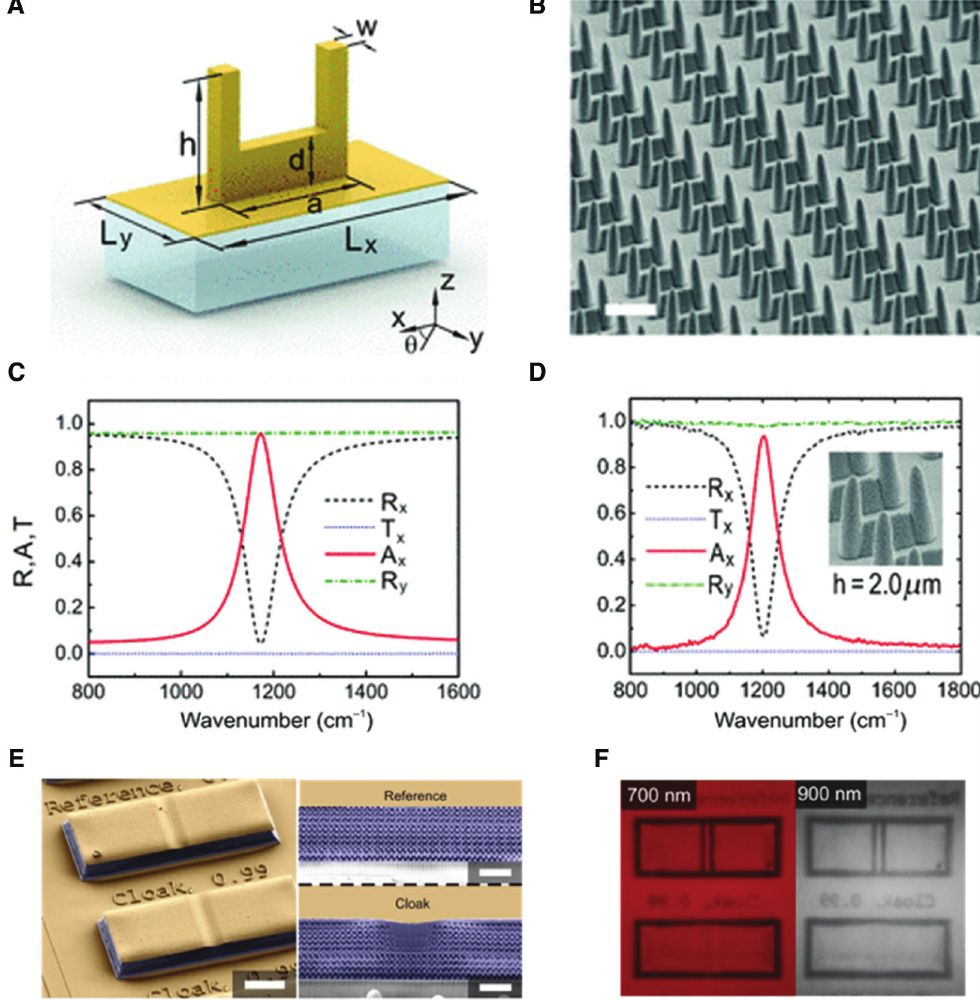
Figure 6: 3D printing for optical metamaterial. = 4 μ m, L = 2 μ m, a = 2 μ m, h = 2 μ m, d = 0.7 μ m, and w = 0.3 μ m. (B) FESEM (A) Schematic of the standing U-shape resonator with L x y micrographs of the SUSRs with h = 2 μ m (scale bar: 2 μ m). (C) Simulation result of the SUSRs with the same parameter of Figure 3B. (D) Measured spectra of the SUSRs with h = 2 μ m. Adapted from Ref. [91]. Copyright (2013) APS. (E) SEM images of reference and cloak samples. The blue color indicates polymers and the yellow one indicates a sputtered gold film (scale bar, 10 μ m). (F) Measured images of reference (top) and cloak (bottom) samples at different wavelengths. Adapted from Ref. [92]. Copyright (2011) OSA